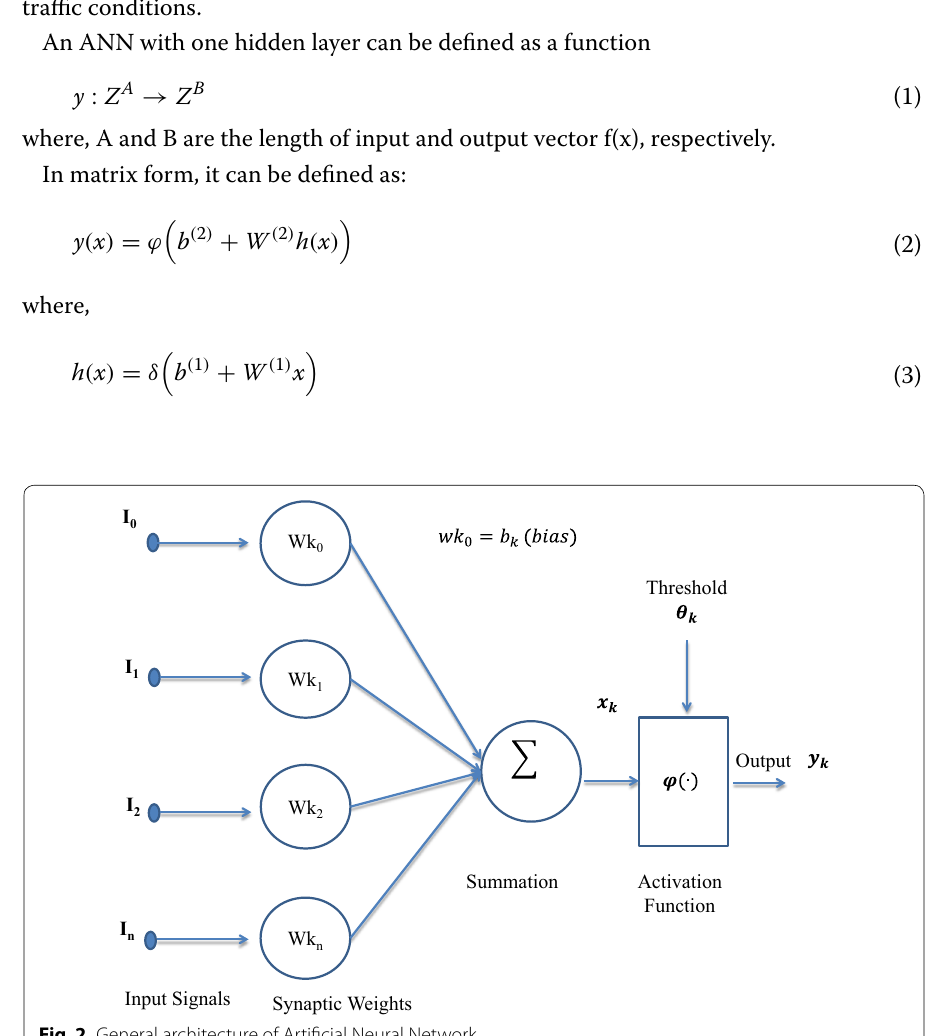
Fig. 2 General architecture of Artificial Neural